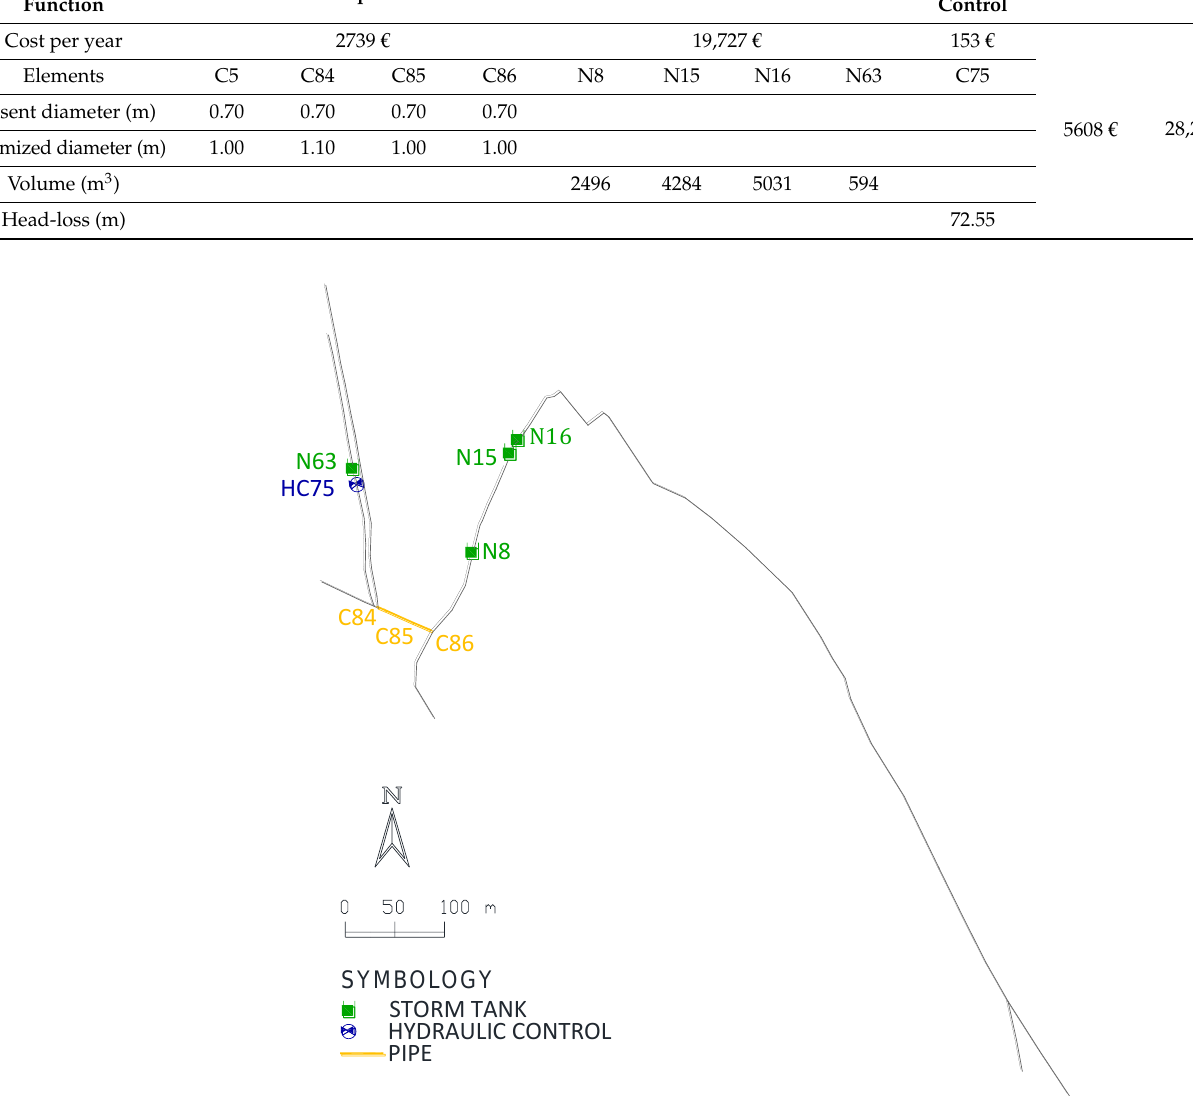
Figure 12. Location of infrastructure needed to rehabilitate the Balloon network (SSR method). Table 2. Results of the final optimization in the Balloon network.